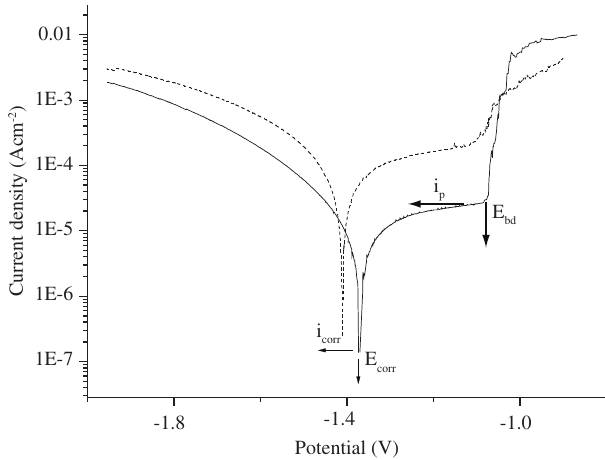
Figure 4. Log i vs. potential polarization curve made in PBS + 0.1 g/L albumin. Passive and corrosion currents (i i ), the breakdown and corrosion potentials p corr (E , E ) are indicated. Dashed line corresponds to the control polarization bd corr curve made in PBS.